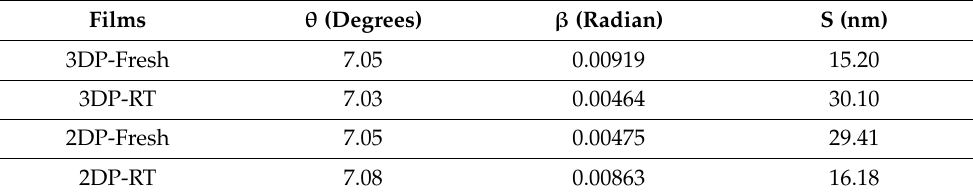
Figure 6. XRD analysis of (a) 3DP and (b) 2DP films. The films in ( a ) ‐ ( i ) and ( b ) ‐ ( i ) are exposed to 90% RH for 30 min., ( a ) ‐ ( ii ) and ( b ) ‐ ( ii ) exposed to RT for 8 h, and ( a ) ‐ ( iii ) and ( b ) ‐ ( iii ) at t = 0 for freshly deposited films; further details on the specific environmental conditions are provided in the caption of Figure 5. For the 3DP films, the amplitude of the (110) peak is diminished significantly even upon exposure to the RT conditions in ( ii ), while for the 2DP film the (111) peak is strongly active even after exposure to the conditions in ( ii ). From the (110) and the (111) peaks for the 3DP and 2DP films, respectively, the grain size S at t = 0 for freshly deposited films and RT exposed samples was computed using the Scherrer formula and the data are summarized in Table 2. Table 2. The grain size S for the fresh and RT exposed samples was computed using the Scherrer formula from the (110) and the (111) peaks for the 3DP and 2DP films, respectively.